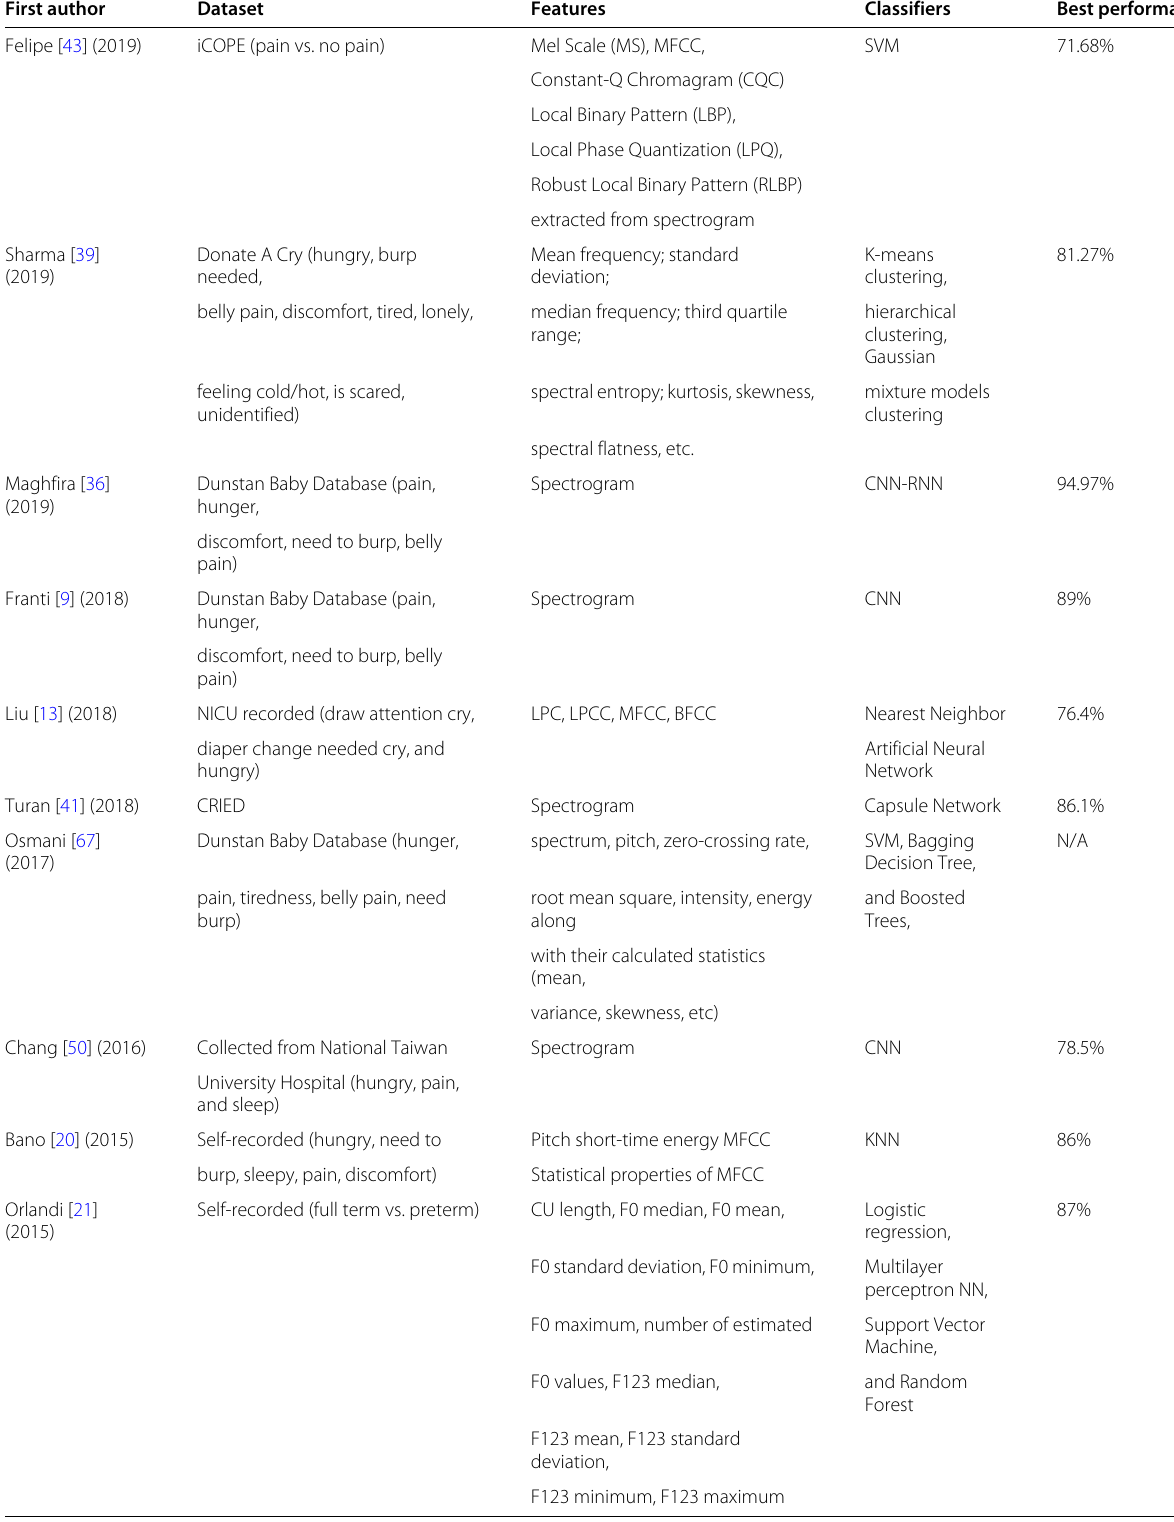
Table 2 Significant works on infant cry reason